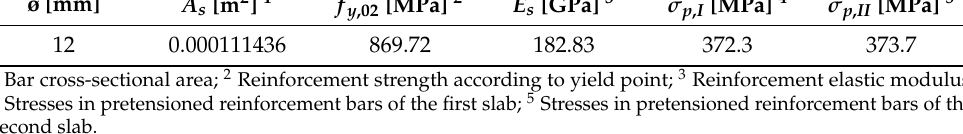
Table 4. Characteristics of pretensioned reinforcements.